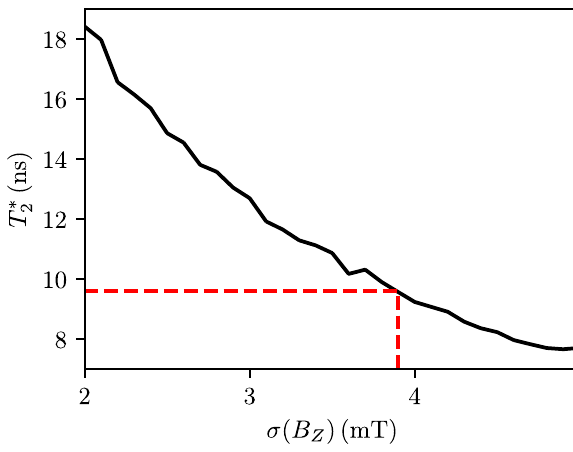
FIG. 8. The simulated spin-coherence time in a static double quantum dot. The electron spin decoherence curves can be simu- lated for different standard deviation σ( B Z ) values of a Gaussian distribution in hyperfine fields. The coherence times extracted from Gaussian fits are plotted as functions of σ( B Z ) . The field = 9.6 ns [extracted corresponding to the spin-coherence time T (cid:5) (cid:2) 2 ( from the T (cid:5) N config ) fit of Fig. 3(f)] is pinpointed with a dashed 2 red line ( B Z = 3.9 mT).